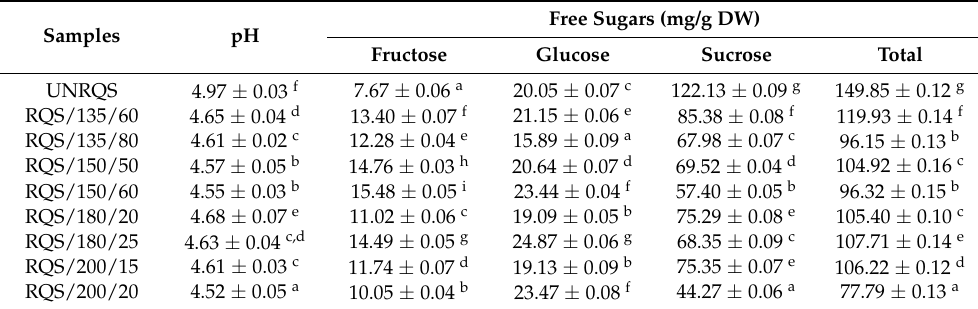
Table 3. Th pH and free sugars content in Q. rubra seeds before and after roasting.